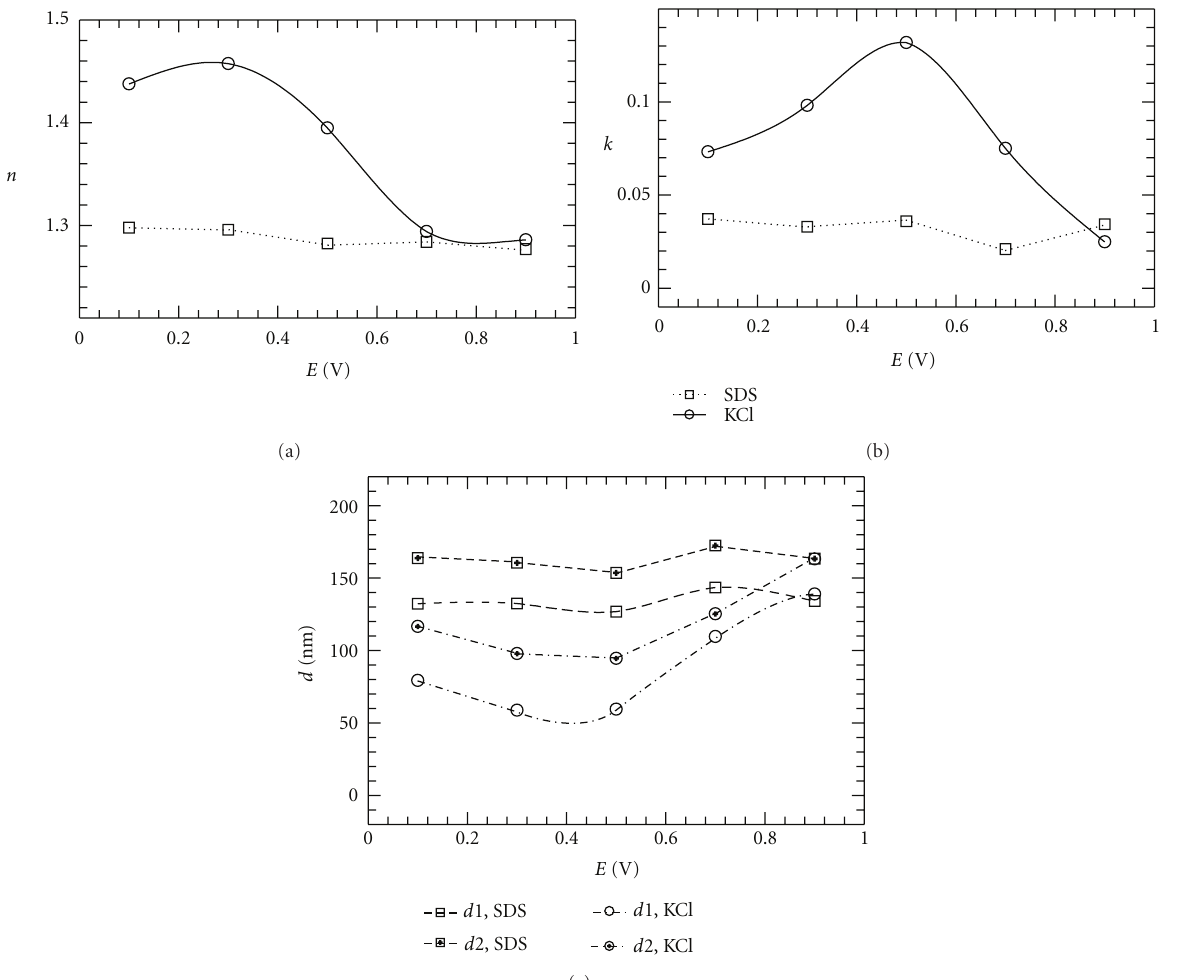
Figure 6: Calculated thickness, d , and optical indices, n , k , for the Ppy layers already described in Figure 5 and for an illuminating light beam of λ = 546 nm. ( (cid:5) ) in SDS and ( (cid:2) ) after immersion in KCl.